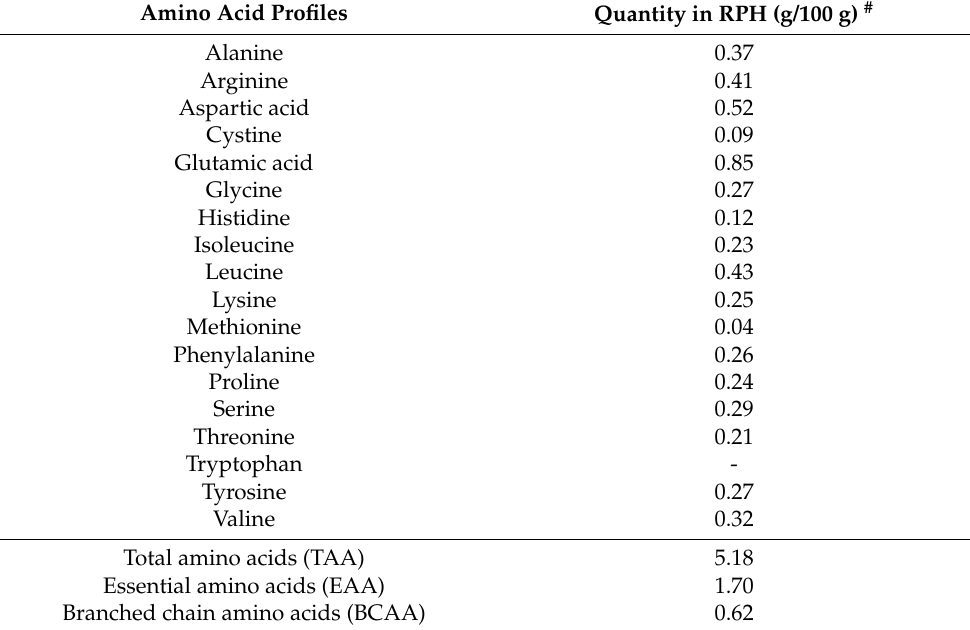
Table 1. Amino acid profiles of rice protein hydrolysate (RPH) samples. Amino Acid